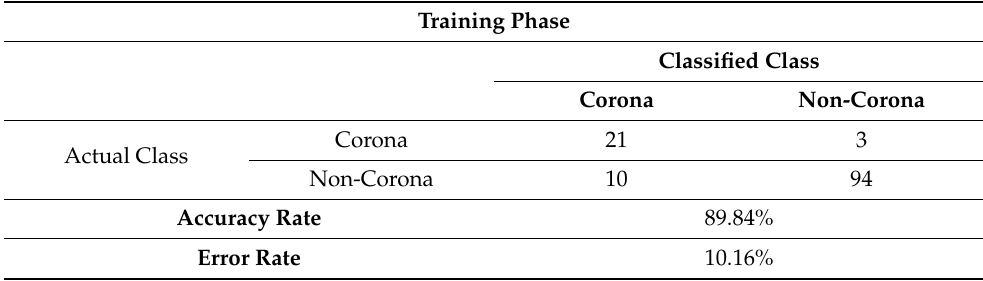
Table 11. Confusion matrix for training phase—frequency domain corona fault classification.